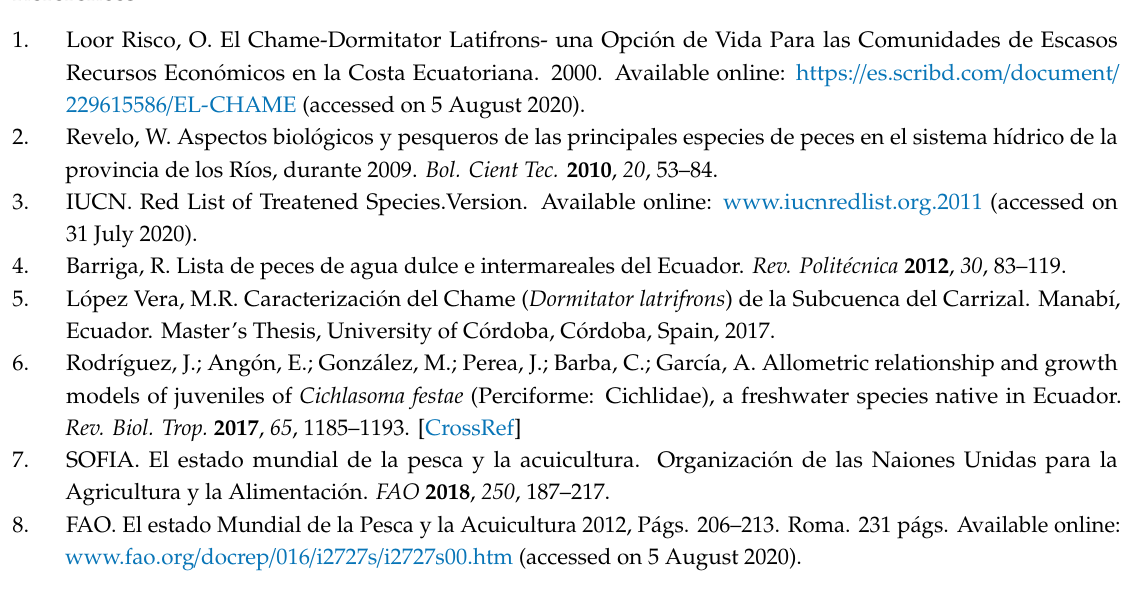
Table S1: Concentrate food for shrimp produced by Agripac S.A; Table S2: Pearson correlation coe ffi cients between morphometric measures of Dormitator latifrons from cultured populations in both sexes (males above diagonal / females upper diagonal); Table S3: Pearson correlation coe ffi cients between morphometric measures of Dormitator latifrons from wild populations in both sexes (males above diagonal / females upper diagonal); Table S4: Discrimination function of the morphometric variables (fitted data) for both sexes, as well as for wild and cultured Dormitator latifrons ; Figure S1: Geographic distribution of Dormitator latifrons ; Figure S2: Sites of capture of Dormitator latifrons : wild (left) and cultured (right); Figure S3: Cultured pool of Dormitator latifrons